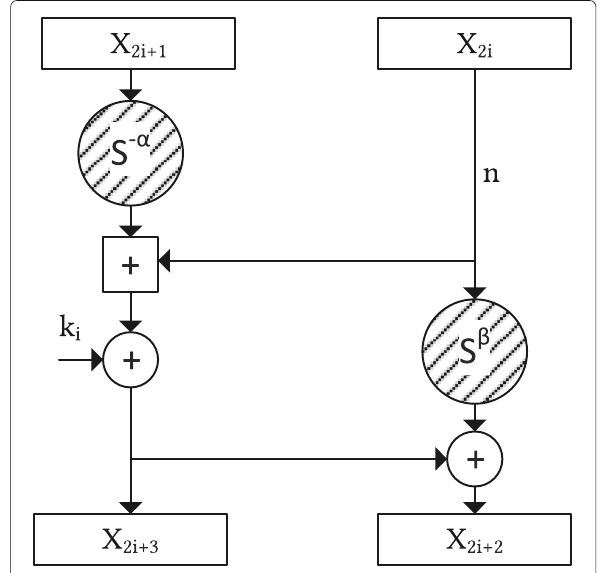
Fig. 9 Round function of